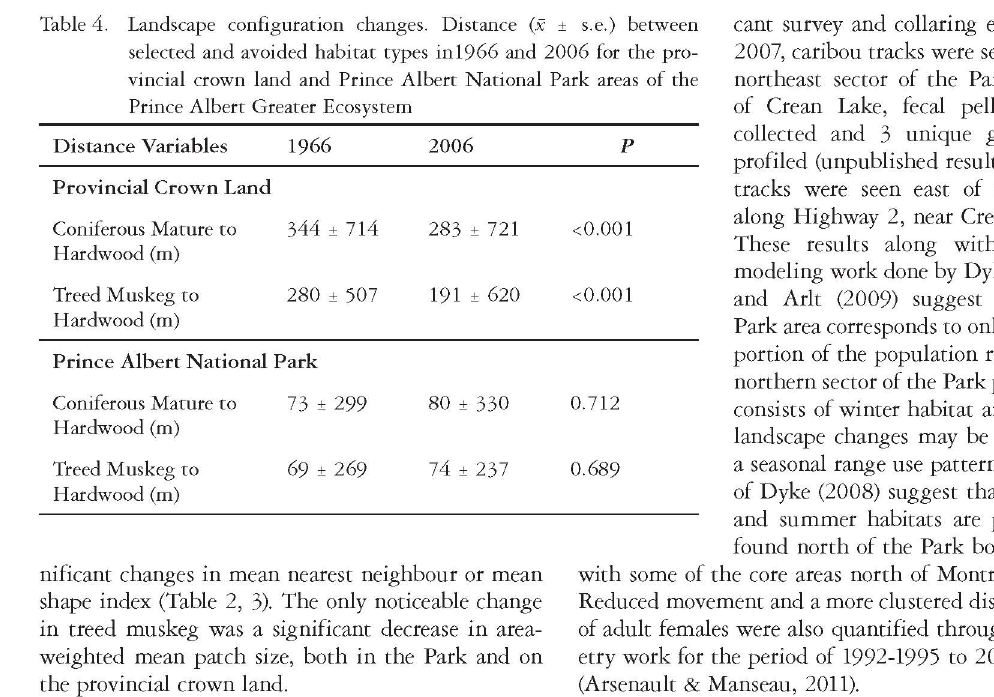
Table 4. Landscape configuration changes. Distance (x ± s.e.) between selected and avoided habitat types in1966 and 2006 for the pro¬ vincial crown land and Prince Albert National Park areas of the Prince Albert Greater